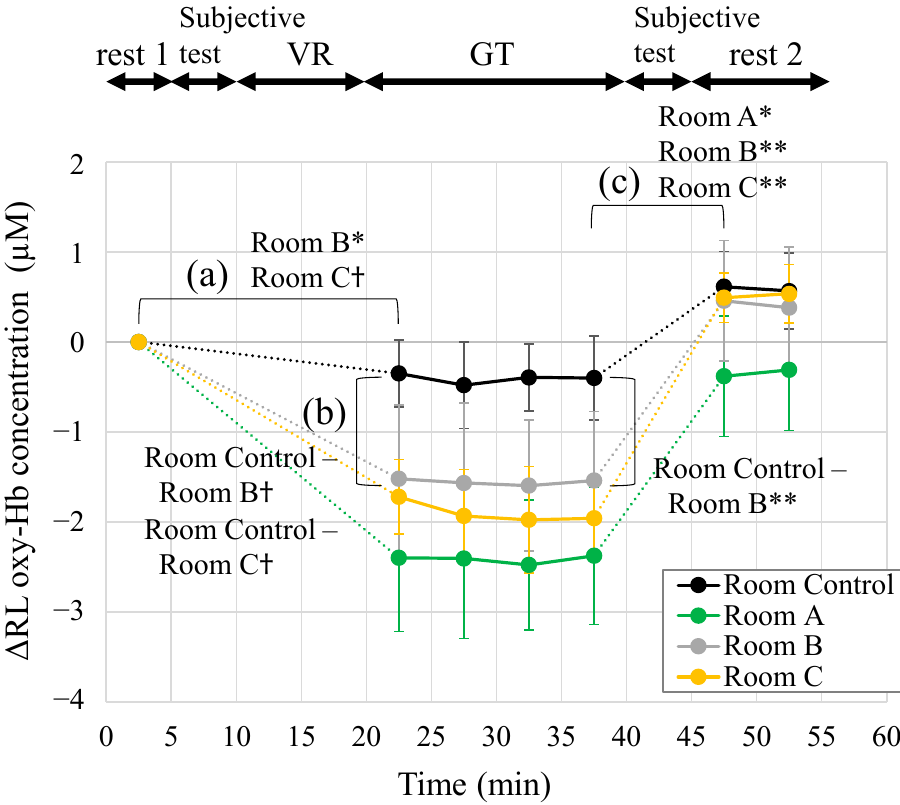
Figure 8. Change in the left-right difference value of the oxygenated hemoglobin (oxy-Hb) in the prefrontal cortex during the experiment (rest 1, GT, rest 2), every 5 min. The vertical axis shows the difference value from rest 1. ( a ) Comparison of rest 1 and the initial 5 min in GT; ( b ) comparison of Room Control and three indoor green spaces, and ( c ) comparison of the last 5 min of GT and rest 2. Data are expressed as mean ± standard errors ( n = 7). ** p < 0.01, * p < 0.05, † p < 0.1. VR, visual reality; GT, test space; Room Control, space without natural green features; Room A/B/C, space with natural green features.